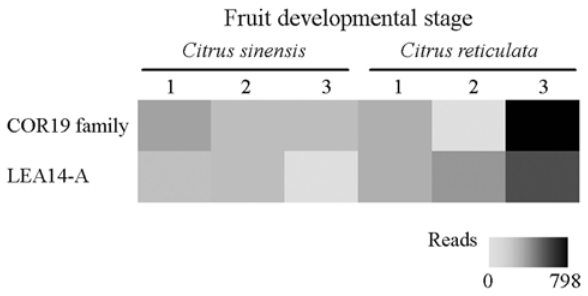
Figure 5 - Expression profile of late embryogenesis proteins-like tran- scripts in fruit development libraries stage 1, 2 and 3 from Citrus sinensis and Citrus reticulata . Data represents the normalized relative number of reads from a specific library showing sequence similarity to the ion trans-